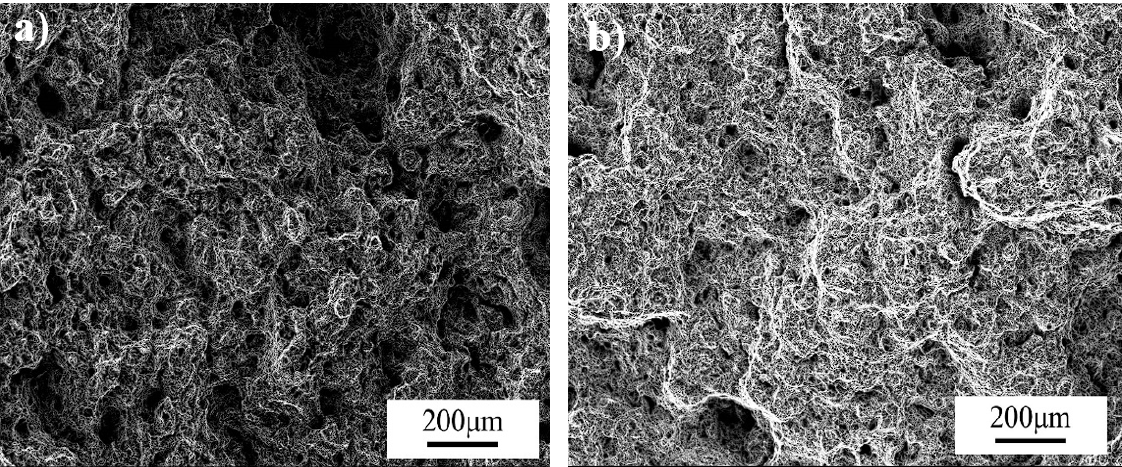
Figure 8. Fracture surface following ratcheting tests for J12: ( a ) 100 ± 800 MPa; ( b ) 100 ± 700 MPa.